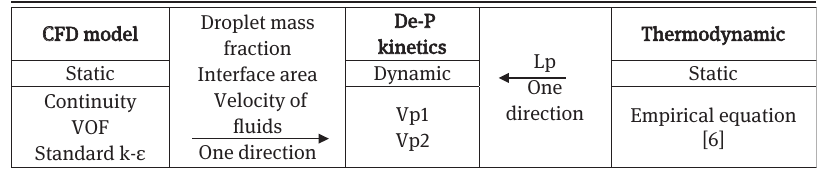
Table 2: Coupling relations of models.